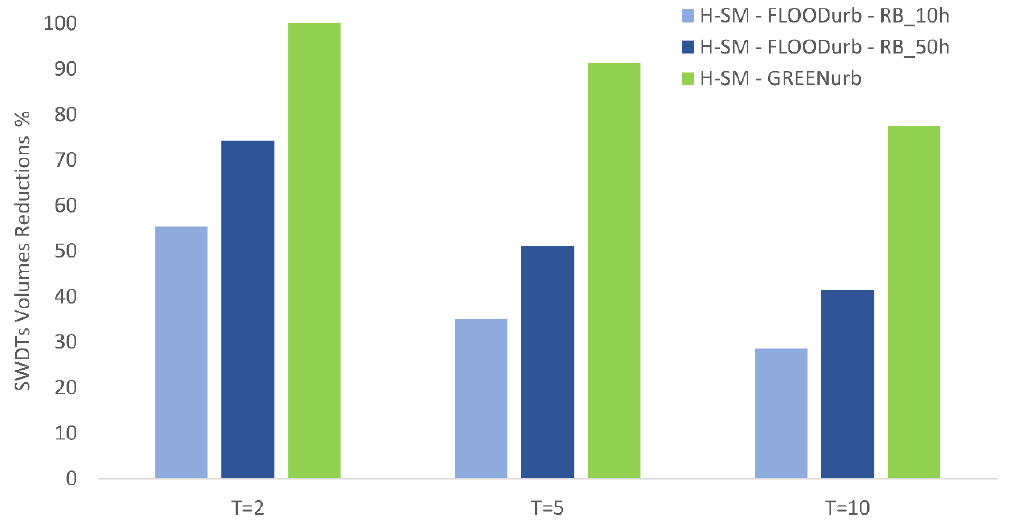
Figure 9. Mean reductions of stormwater volumes to be discharged into SWDTs (D).